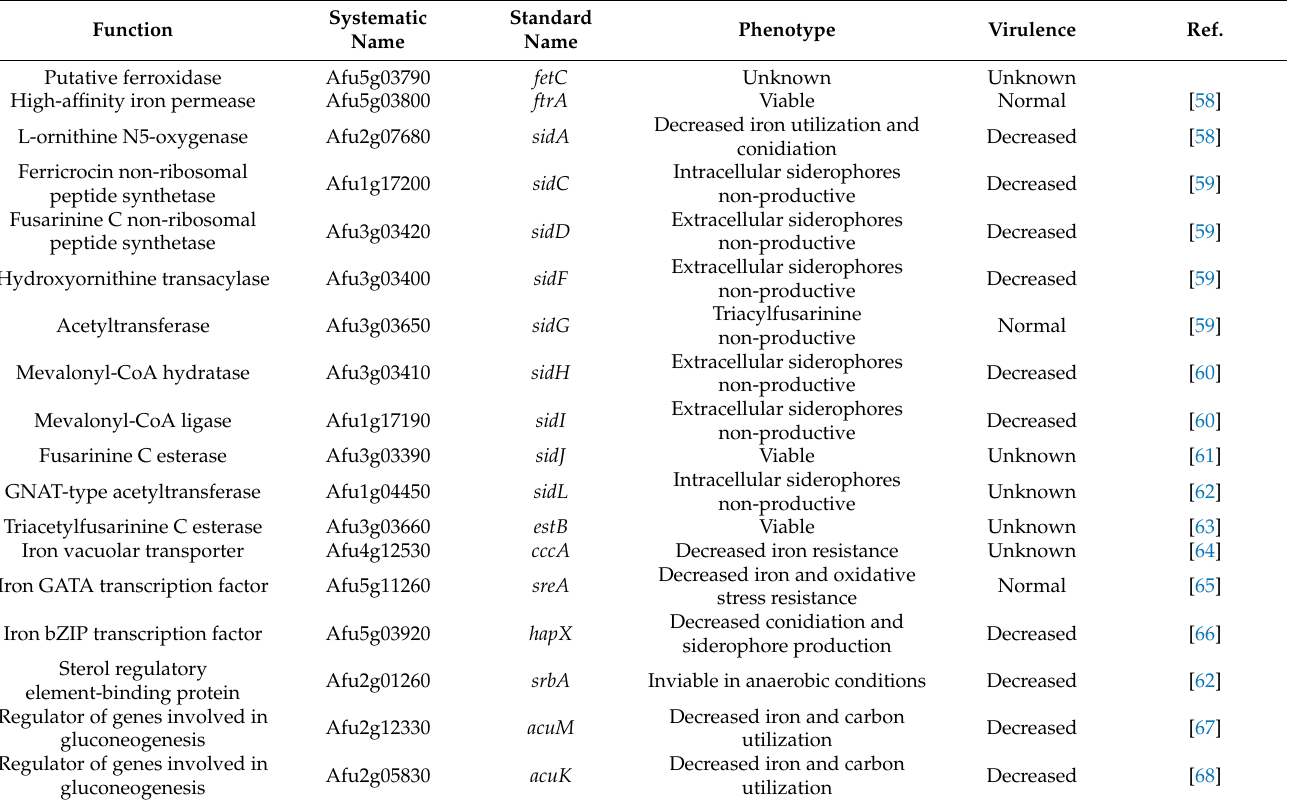
Table 2. A. fumigatus genes implicated in iron metabolism and their implication for fungal phenotype and virulence.